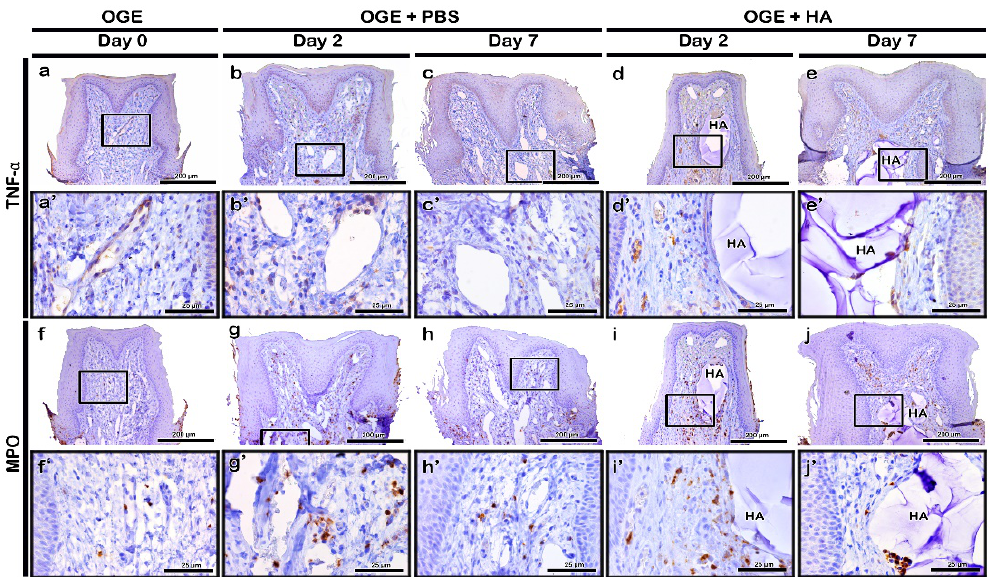
Figure 5. Immunolocalization of tumor necrosis factor (TNF)- α and myeloperoxidase (MPO) in interdental papilla (IDP) after phosphate buffer saline (PBS) or hyaluronic acid (HA) filler injection. The localization patterns of TNF- α ( a – e ) and MPO ( f – j ) in IDP on days 2 and 7 post-PBS ( b , c , g , h ) or HA filler ( d , e , i , j ) injection. Higher magnification view of box in a–j ( a ’– j ’). Scale bars: 200 μm ( a – j ) and 25 μm ( a ’– j ’).